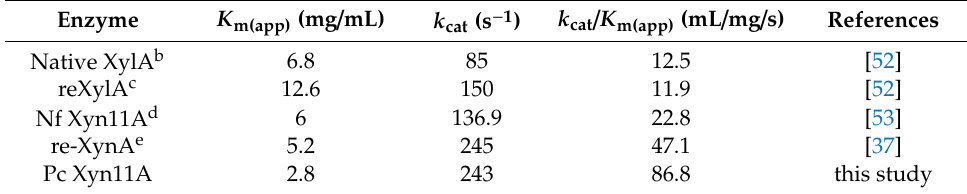
Table 3. Comparison of enzymatic properties between Pc Xyn11A and those of other family 11 β -1,4 xylanases.